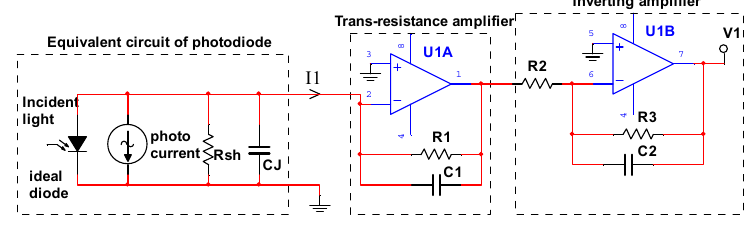
Figure 5. Photodiode equivalent conditioning circuit.